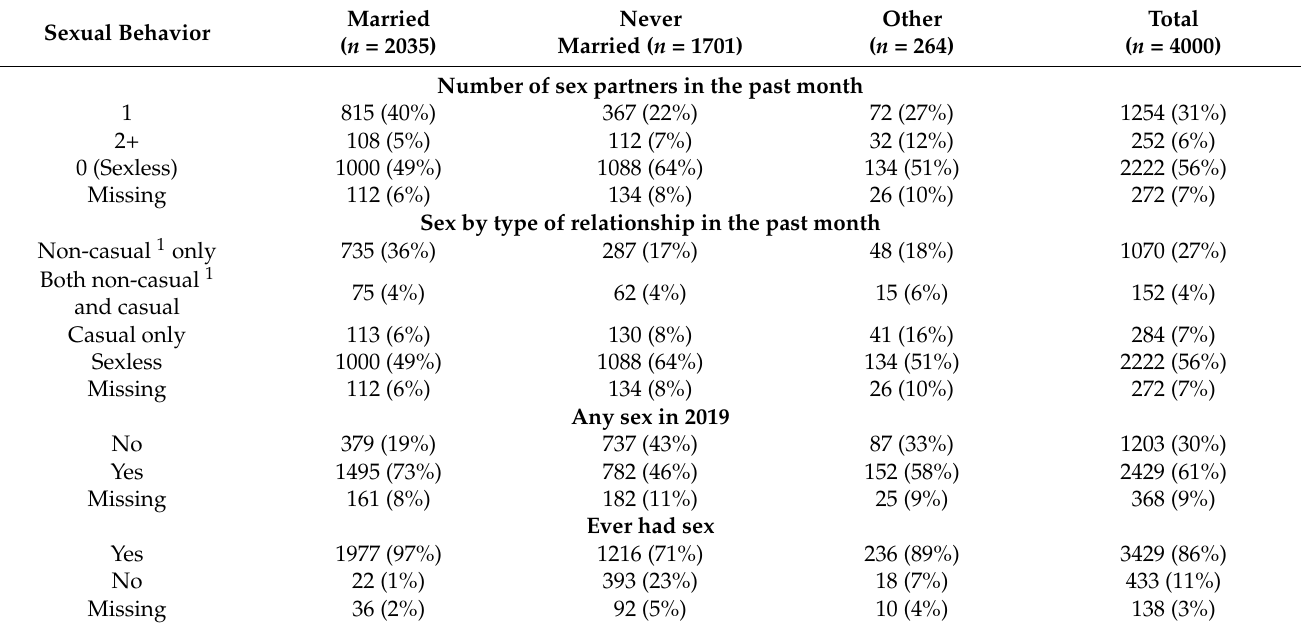
Table 3. Sexual behavior in the past month and in 2019 and experience of sex by marital status ( n = 4000). Married Sexual Behavior ( n =